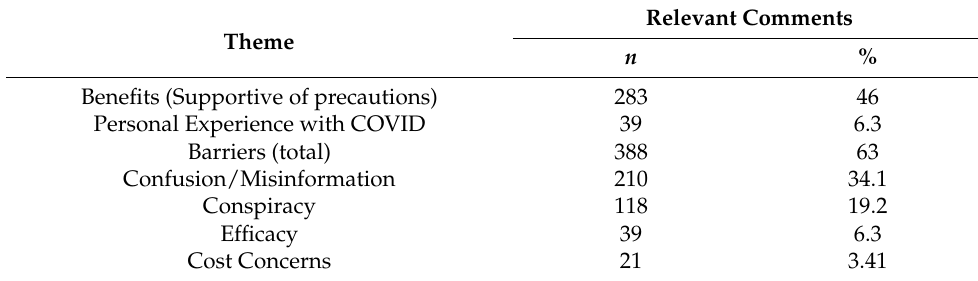
Table 1. Totals of